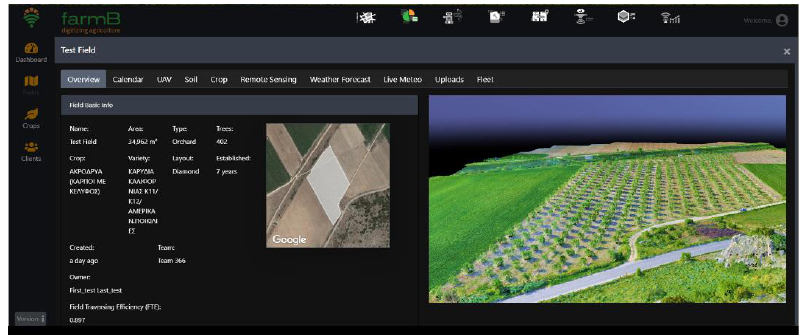
Figure 6. Field maps from farmB software interface presenting ( a ) soil ECa scanning at 0.65 m depth, ( b ) soil ECa scanning at 1.4 m depth, ( c ) the surface elevation map of the field, and ( d ) the management zones delineated using fuzzy clustering analysis on the soil ECa and surface elevation data.